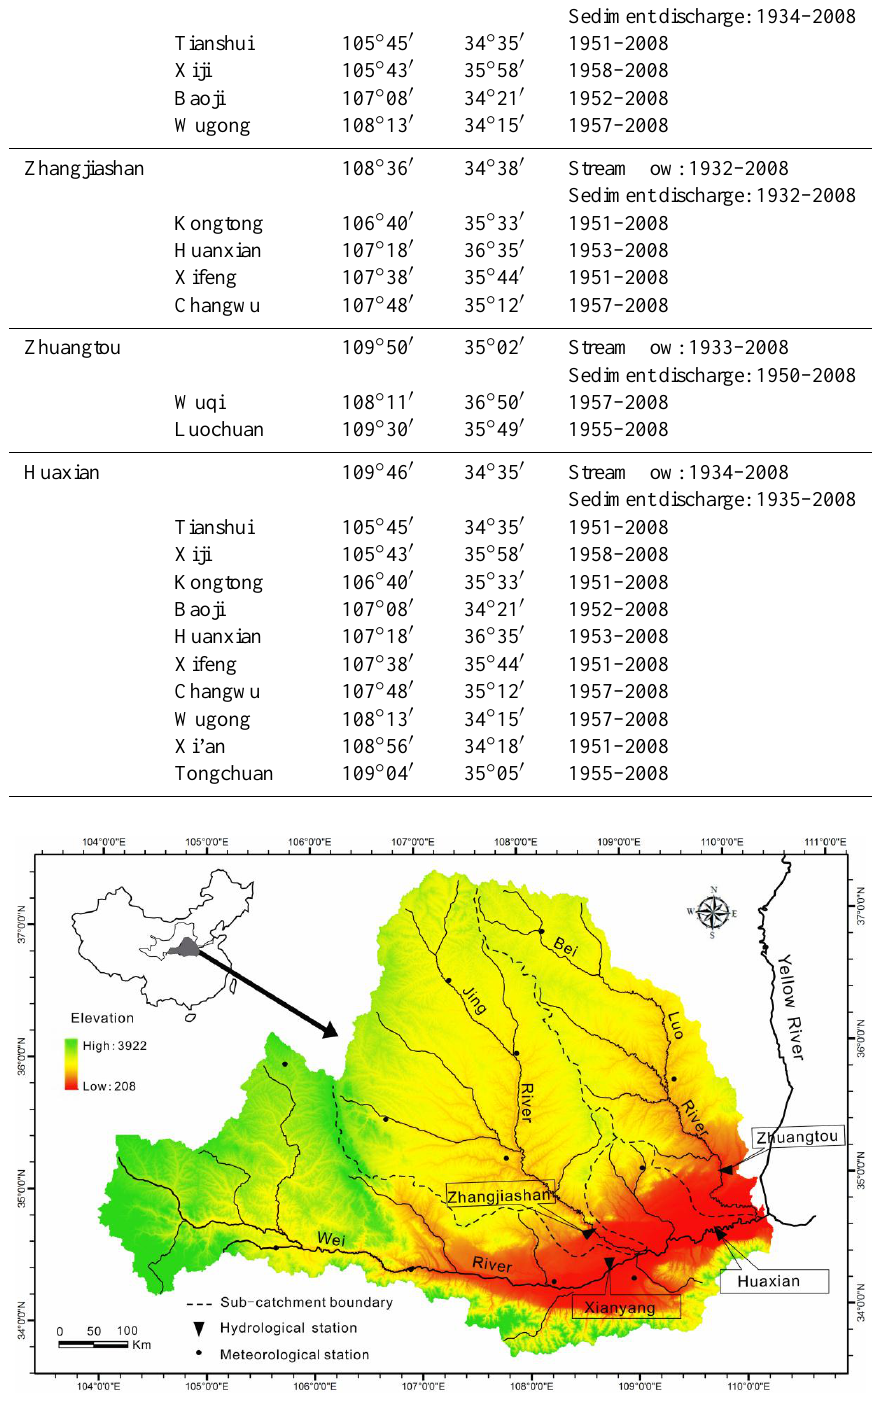
Fig. 1. Location of the study region and hydrological and meteorological stations in the Wei River